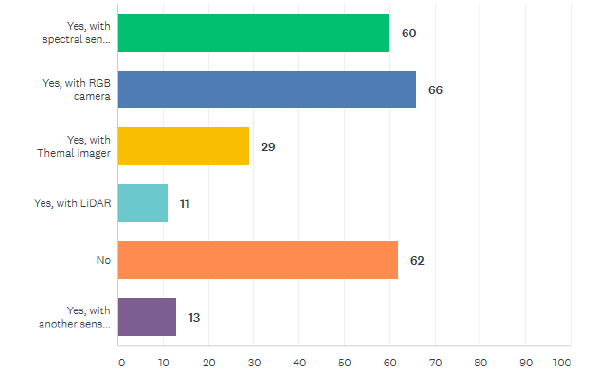
Figure 1 Results of the question: Do you have your own sensing system (sensor and UAV)? And if yes, what sensors do you deploy on it (multiple answers possible)?